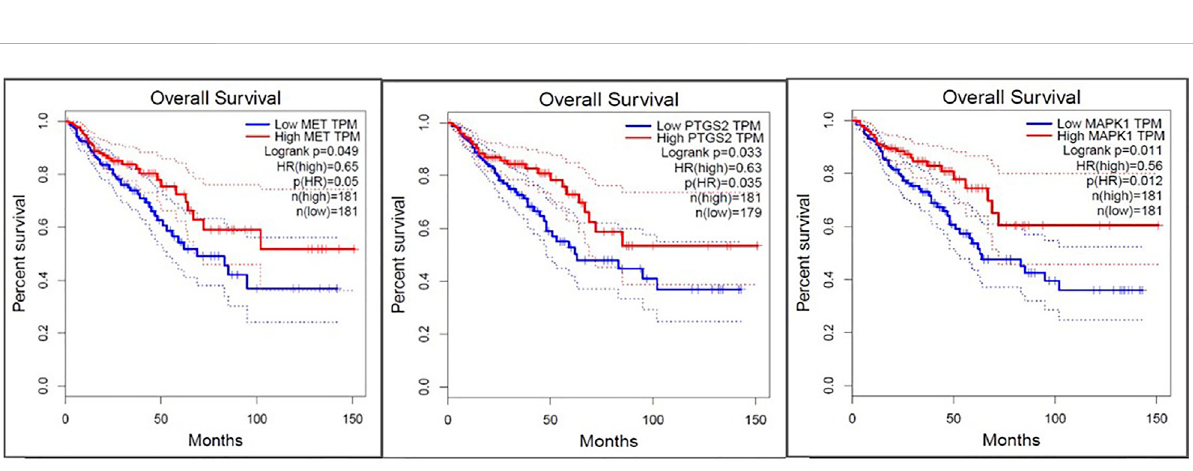
FIGURE 8 Analysis of the correlations between the fi ve genes PTGS2, MMP9, MET, MAPK1, and PDGFRA using Pearson ’ s coef fi cient analysis at p < 0.05. Positive correlation between the genes is shown in green colour, negative correlation between the genes is shown in red color, and genes with no correlation is shown in blue colour *-indicates the correlation is signi fi cant and ***-indicates the correlation is highly signi fi